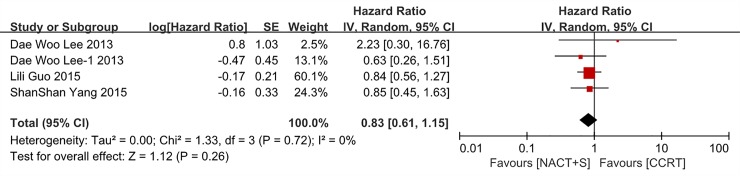
Forest plot of overall survival (OS) for patients with stage IIB cervical cancer.